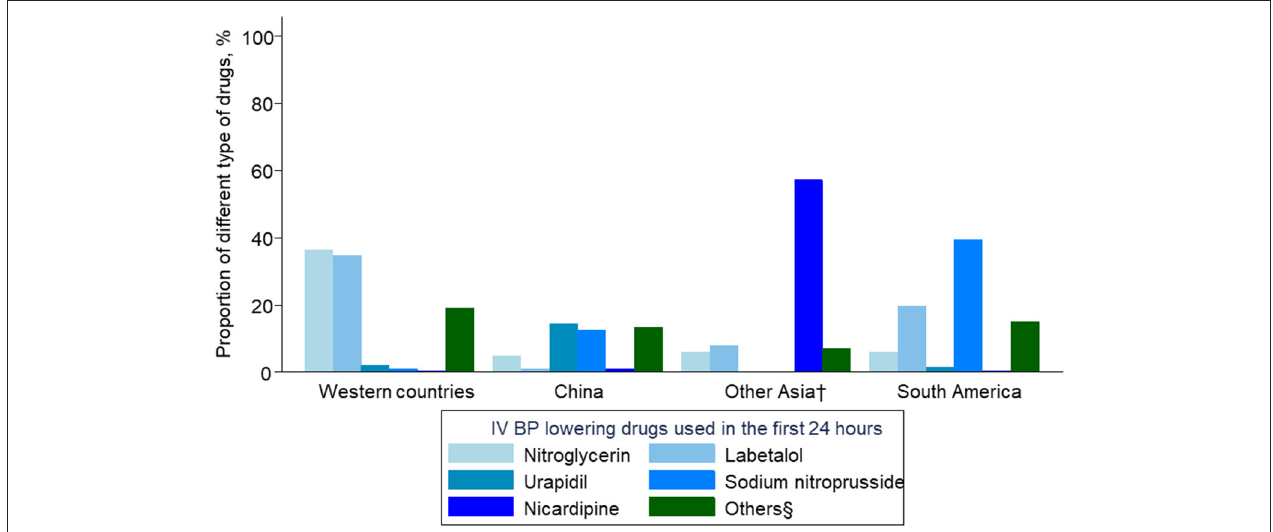
FIGURE 1 | Intravenous blood pressure–lowering drugs used in the first 24h. BP denotes blood pressure; IV intravenous. † South Korea/Hong Kong area/Taiwan area/Singapore/Thailand/Vietnam. §metoprolol, atenolol, clevidipine, nimodipine, nifedipine, urapidil, isodinitrate, frusemide, prazosin, hydralazine, clonidine, and